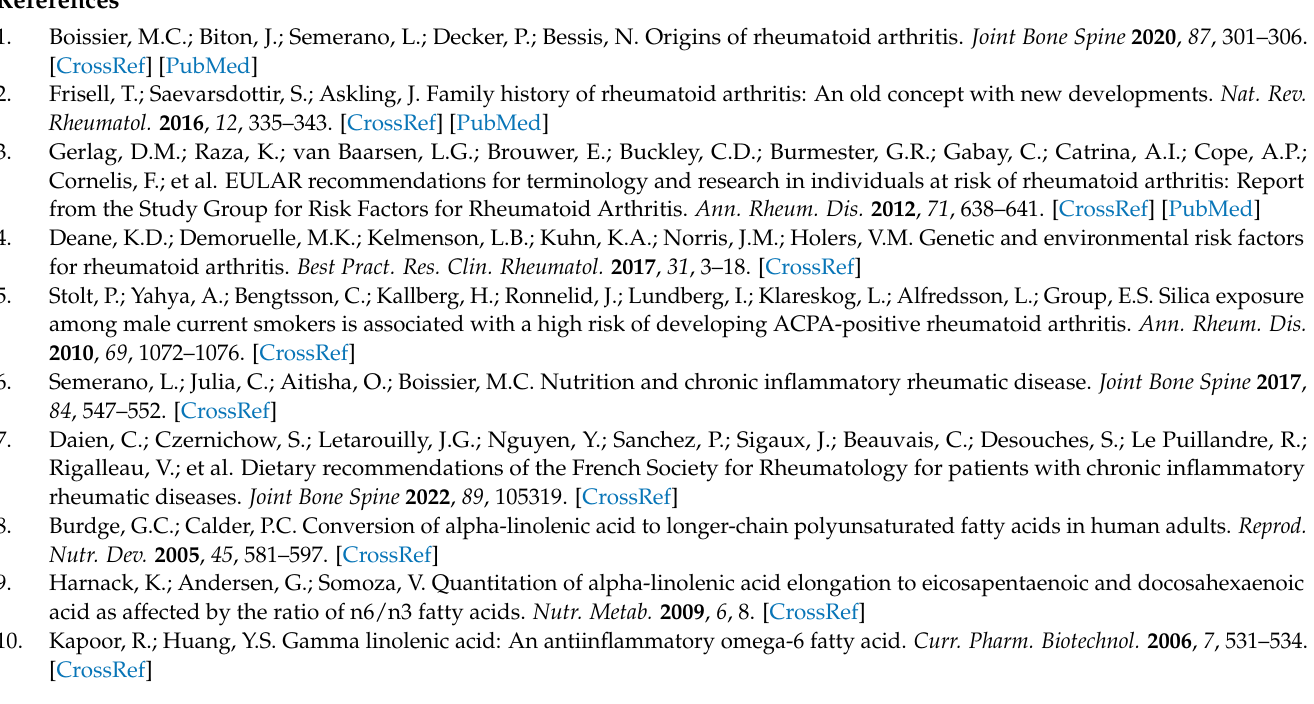
Table S4. Multivariate analysis of the association between FA patterns and 6-month moderate to